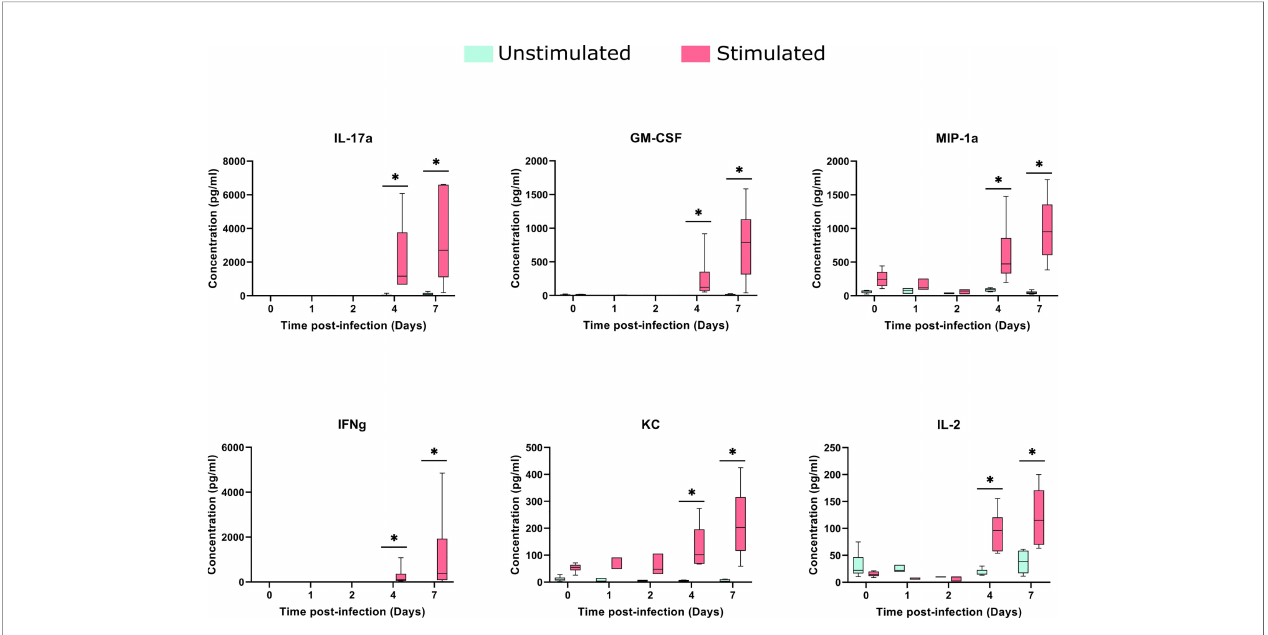
FIGURE 6 | Cytokines concentrations in the spleens after TIGR4 pneumococcal infection. The spleens were collected from infected mice at different time points and splenocytes were cultured for 72 hours in the presence or not of a stimulus (formalin-inactivated TIGR4 pneumococcal strain). The supernatants were collected and the concentration of 23 cytokines were assessed by Luminex immunoassay. Data was analyzed using GraphPad Prism software. To compare Stimulated to Unstimulated samples we used the Wilcoxon paired test. Concentrations from six of the cytokines are presented in the fi gure (for all the 23 cytokines see Supplementary Image 3 ). When compared to only infected samples, all the six cytokines presented a signi fi cant (*= P <0.05) increase when stimulated in days 4 and 7 after